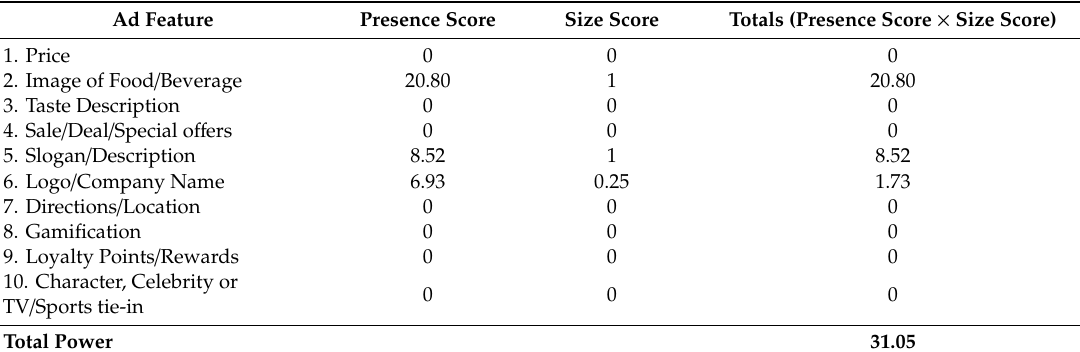
Table 6. Coding example using the teen-developed tool: Advertisement B.